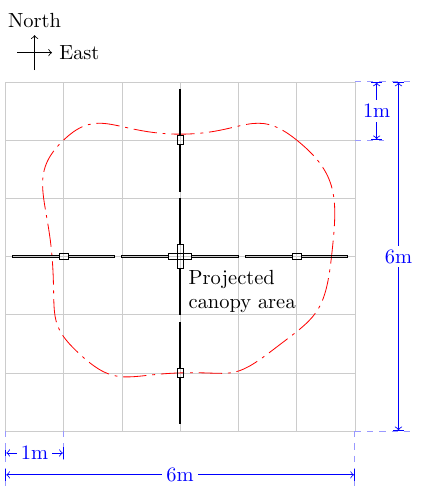
Figure 8. Using AccuPAR LP-80 to collect the below-canopy photosynthetically-active radiation (PAR) reading along quadrantal